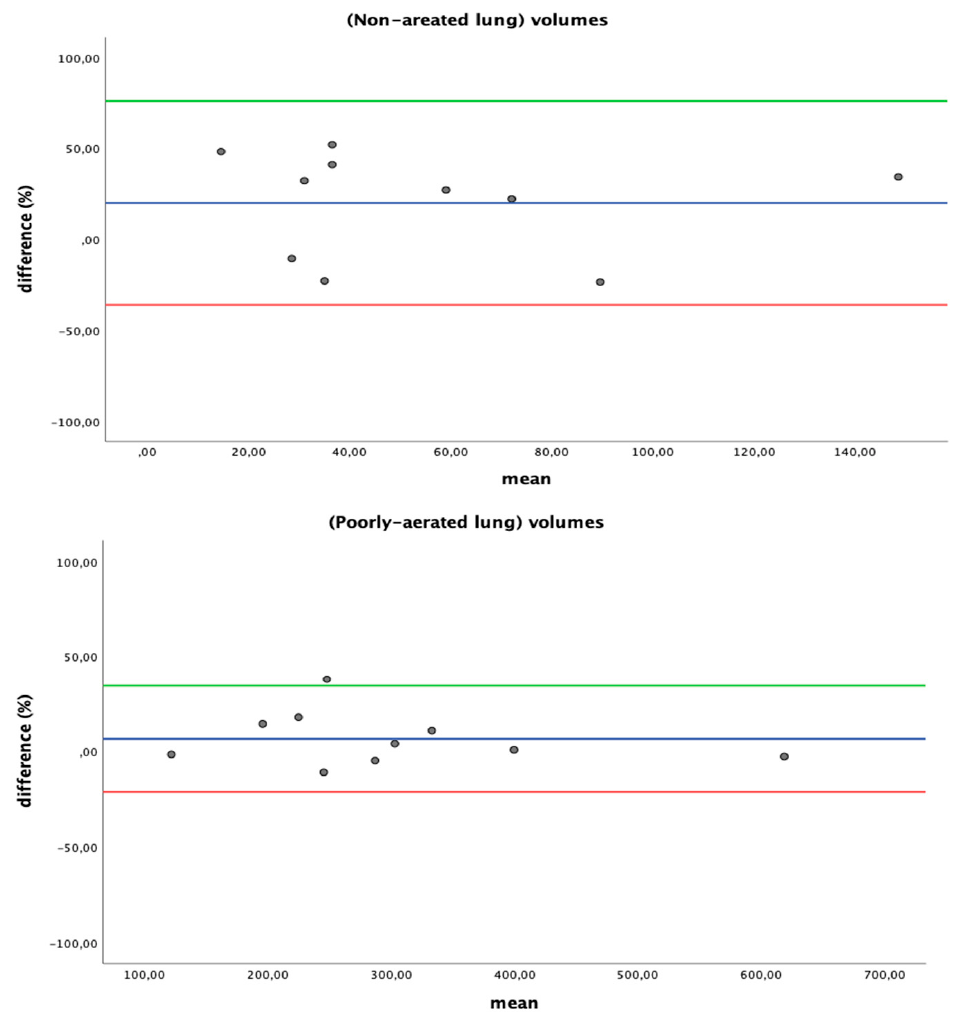
Figure 4. Bland–Altman plots for agreement between different readings; differences are plotted as percentage.